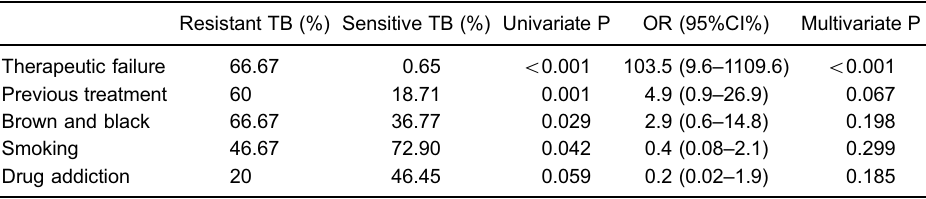
Table 2. Model of logistical regression of the independent variables that showed association with resistance in univariate